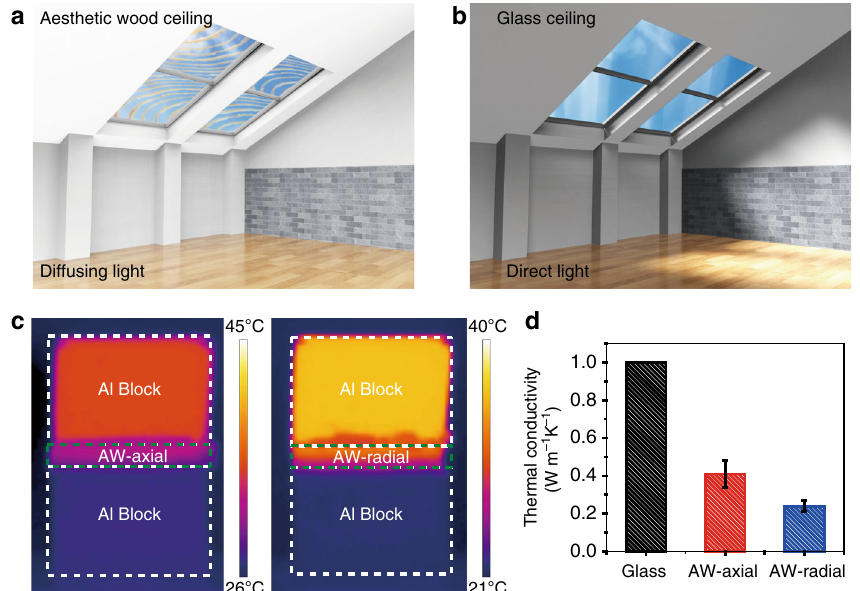
Fig. 5 Light guiding effect and thermal insulation properties of aesthetic wood. a - b The schematic scene shows the light distribution and aesthetic appeal inside a building via applying the aesthetic wood (abbreviated as AW in the d ) ceiling comparing with the glass ceiling. c IR images of aesthetic wood with temperature distributions in the axial (heat transfer direction is parallel to the aligned wood microchannels) and radial (heat transfer direction is perpendicular to the aligned wood microchannels) directions. d Thermal conductivities of glass 9 , axial and radial direction of our aesthetic wood (AW). Error bars represent standard